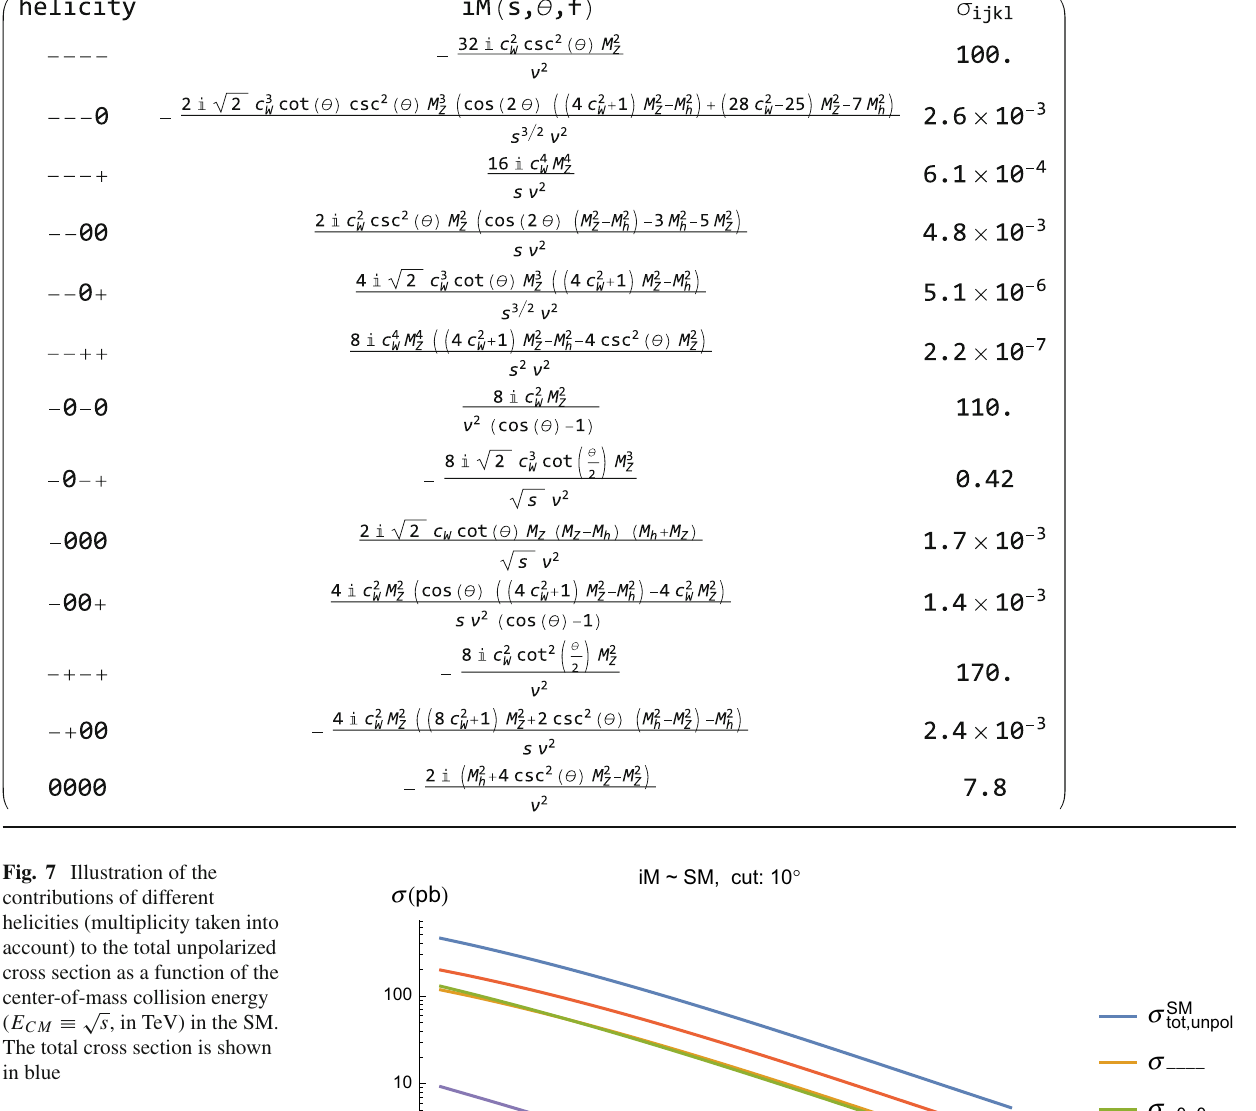
contributions from the helicities to the total unpolarized cross section at 1 TeV; c W is the cosine of the Weinberg mixing angle, v is the SM